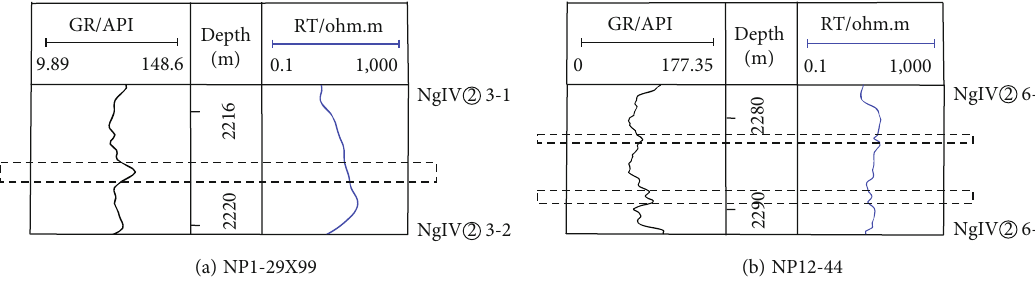
Figure 12: Identi fi cation mark of muddy interlayer in Nanpu 1-29